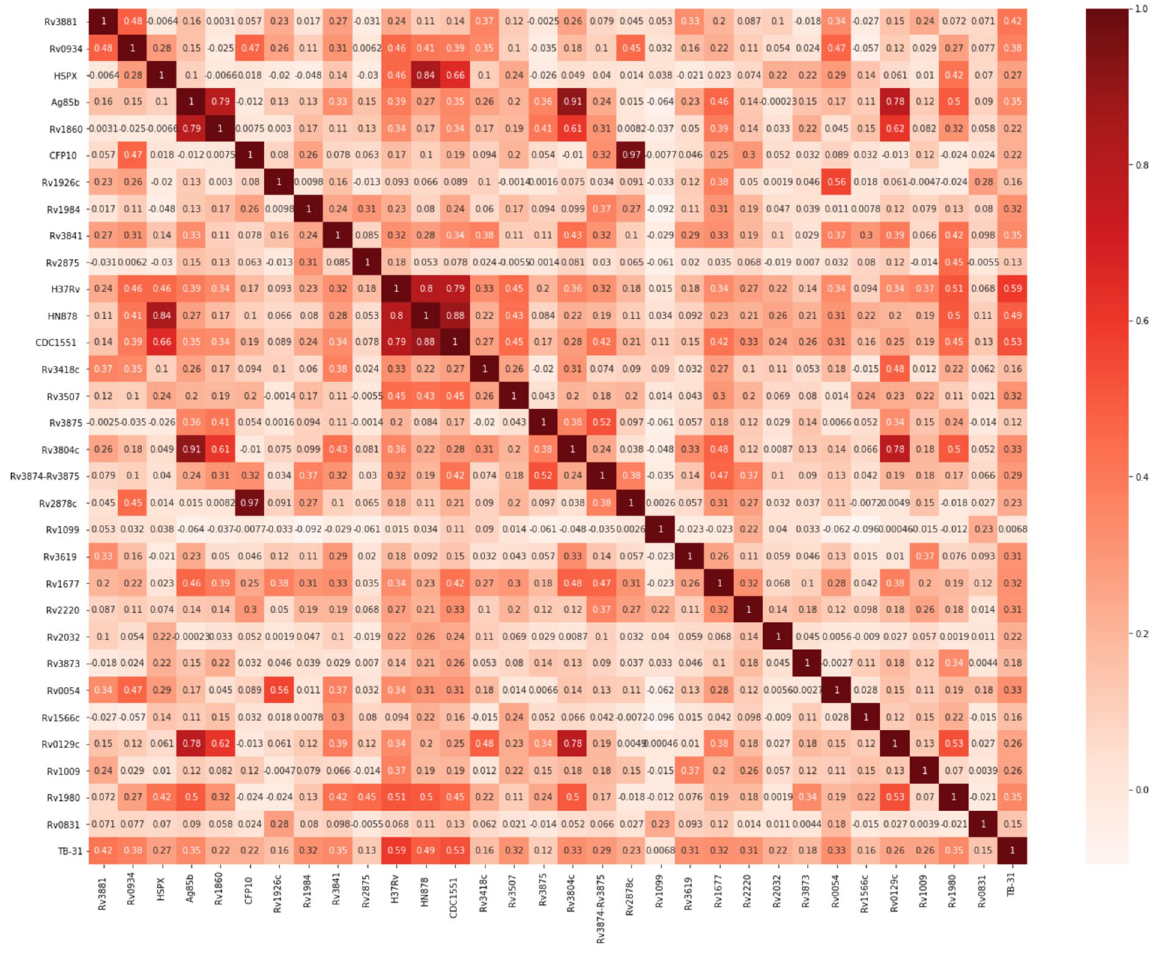
Figure 3. Pearson standard correlation coefficient for TB multiplex microbead immunoassay data. Correlations between the various antigens tested as well as the clinical presence of tuberculosis (here denoted as TB31) is depicted in a